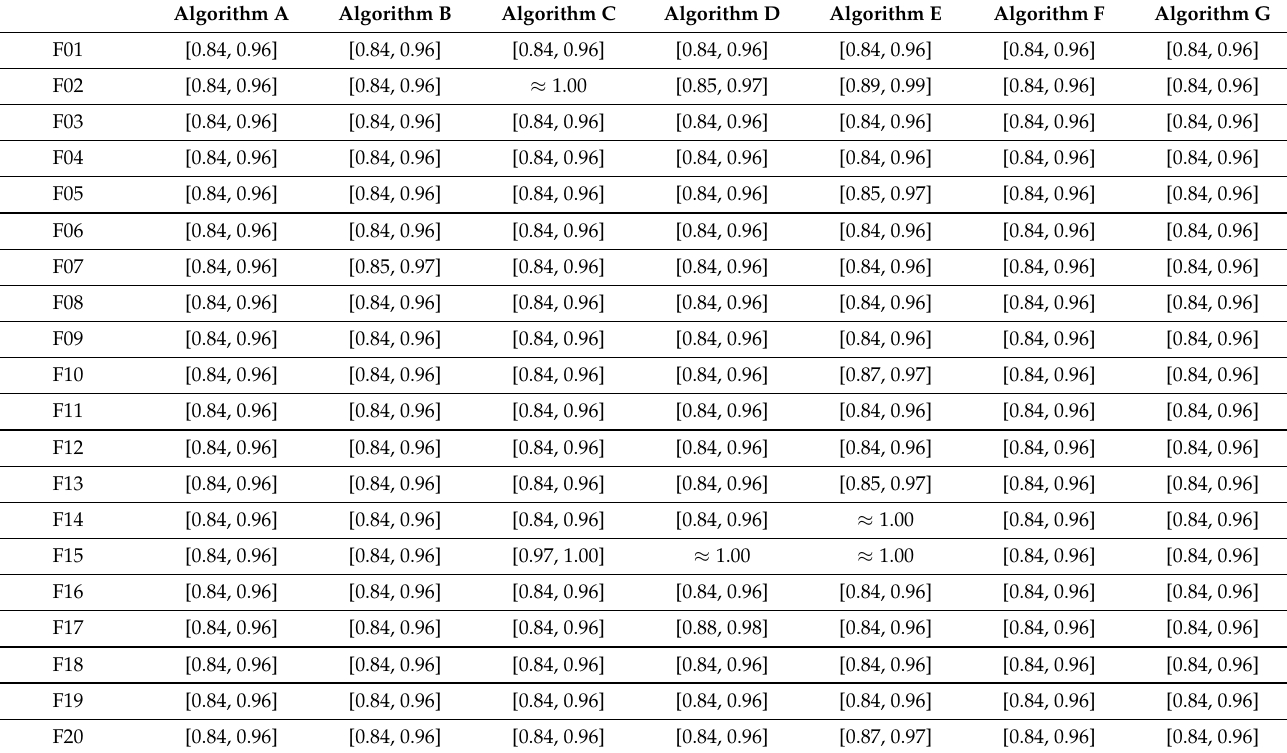
Table 15. Confidence intervals of the probability for sample quantiles Q 0.90 of solution